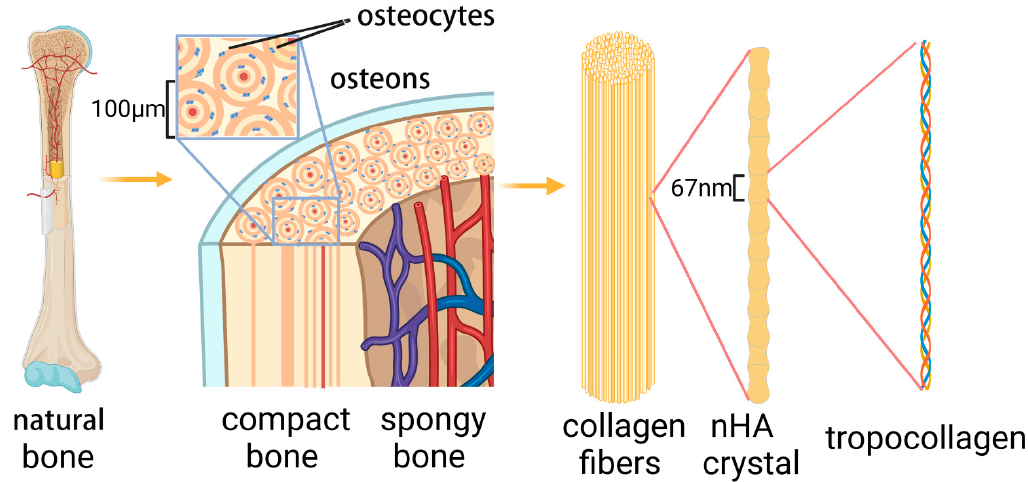
Figure 3. Hierarchical structure of bone from macroscale to molecular composition. Natural bone is primarily composed of compact bone and spongy bone. Compact bone includes external circumferential lamellae, internal circumferential lamellae, osteons (Haversian canals) and interstitial lamellae. Osteocytes are surrounded by osteons. Bone has a lamellar structure, and a single lamella is composed of collagen fibers; three amino acid chains and nHA form collagen molecules (procollagen). Olszta et al. aligned nHA crystals along the axis of collagen fibers to mimic native bone nanostructures [31]. Some scholars also used a co-titration method of phosphate collagen (COL) solution and calcium hydroxide solution under the assistance of microwave.